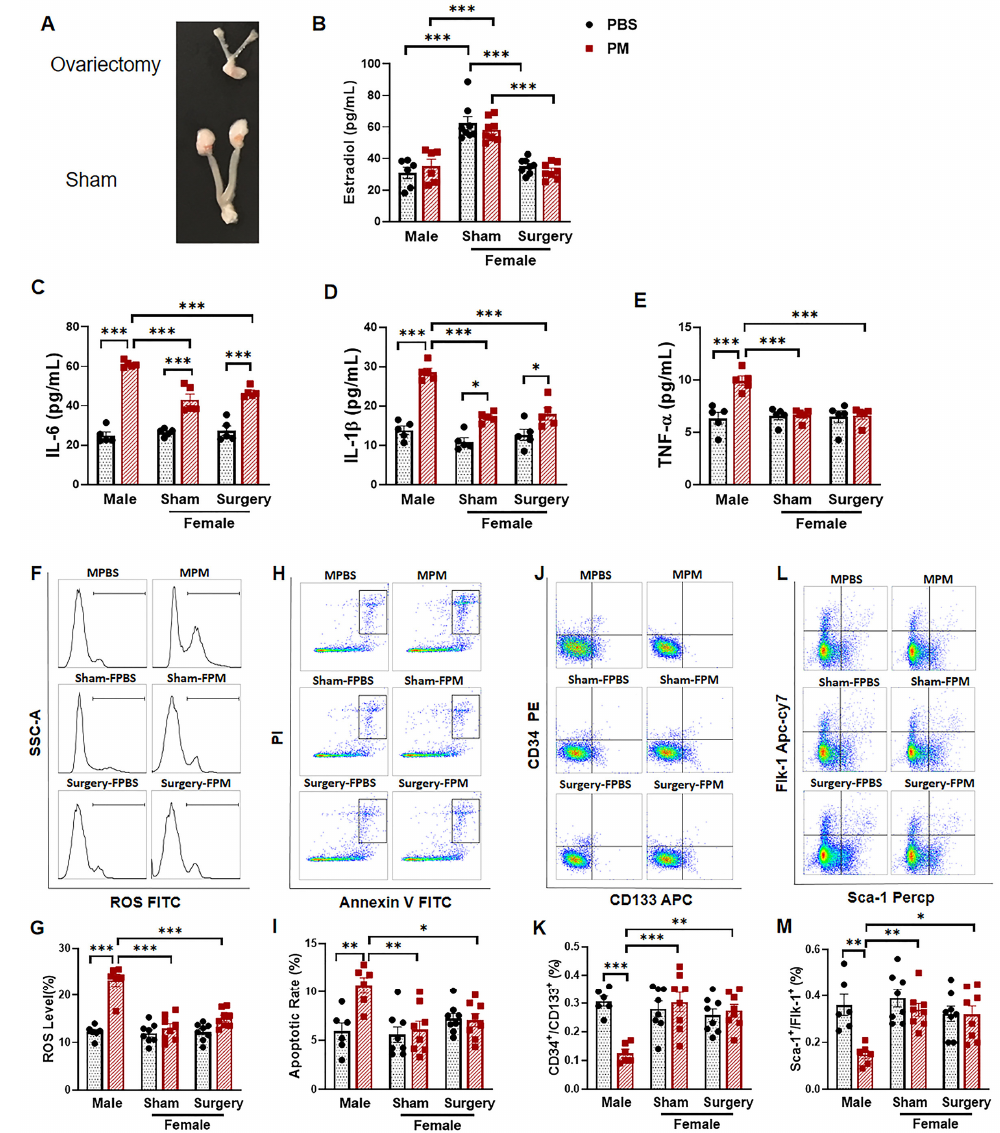
Figure 4. The protective effect on circulating EPCs in female mice with PM exposure was independent of estrogen. ( A ) The size of the uterus and ovary tissue from female mice with ovariectomy was much smaller than that from female mice with sham operation. ( B ) Serum level of estradiol was significantly decreased in female mice with ovariectomy to a level similar to male mice. ( C,D ) Pro-inflammatory cytokines IL-6 (C) and IL-1 β (D) in male mice with PM exposure were significantly higher than female mice with or without ovariectomy. ( E ) Elevated serum levels of TNF- α induced by PM exposure were only observed in male mice, not in female mice with or without ovariectomy. ( F ) Flow cytometry analysis was used to detect the ROS in blood monocytes, with summary data ( G ) showing that a significant increase in ROS production was observed in male mice with PM exposure, but not in female mice with or without ovariectomy after PM exposure. ( H ) Blood cells were incubated with annexin V and PI for apoptosis analysis, with summary data ( I ) showing a significant increase in the apoptotic rate only in male mice with PM exposure, not in female mice with or without ovariectomy ( G ). ( J,L ) Flow cytometry analysis for circulating EPC (CD34 + /CD133 + ) or (Sca-1 + /Flk-1 + ), with summary data ( K , M ) showing a significantly decreased circulating EPC population in male mice after PM exposure, not in female mice with or without ovariectomy. MPBS: male mice with PBS treatment ( n = 6); MPM: male mice with PM exposure ( n = 6); Sham-FPBS: female mice with intact ovary and PBS treatment ( n = 8); Sham-FPM: female mice with intact ovary and PM exposure ( n = 8); Surgery-FPBS: female mice with ovariectomy and PBS treatment ( n = 8); Surgery-FPM: female mice with ovariectomy and PM exposure ( n = 8). (C–E) n = 5 for each group. * p < 0.05, ** p < 0.01, and *** p <